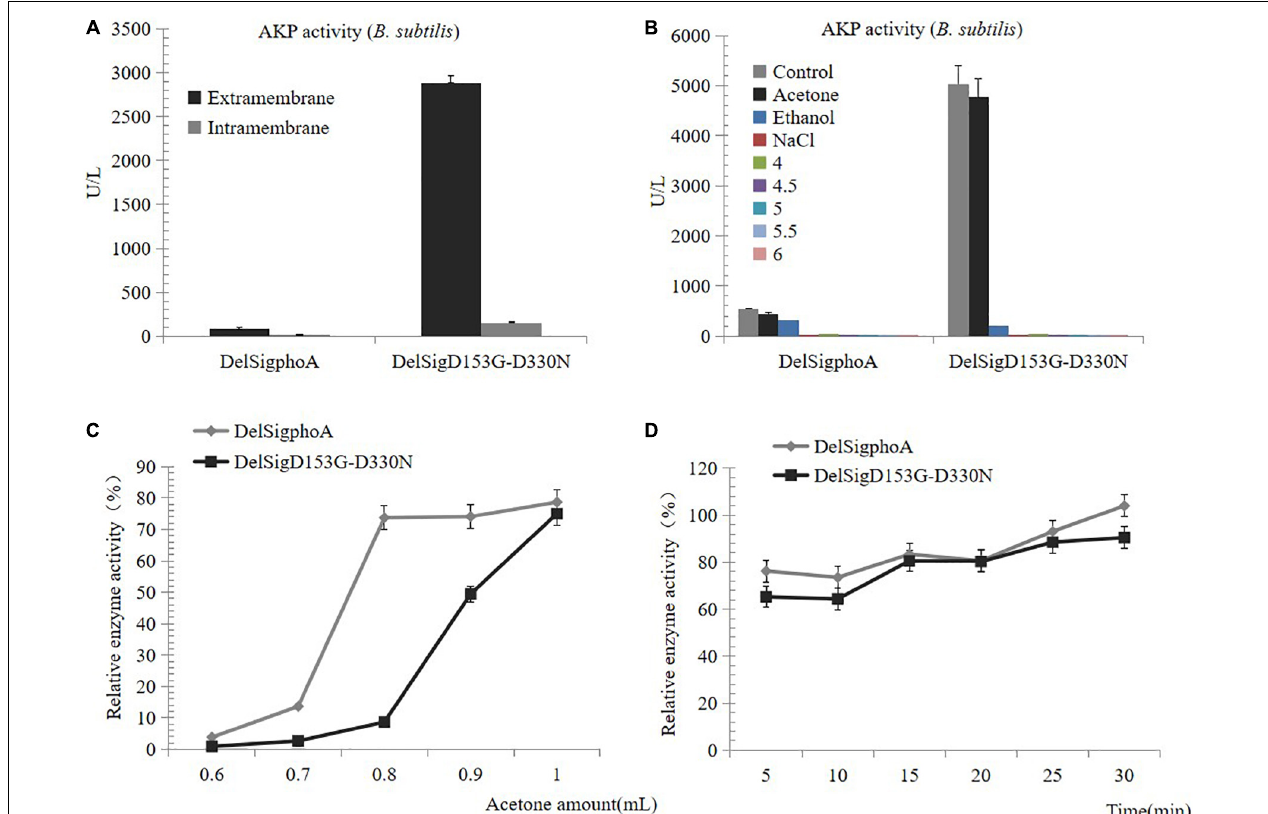
FIGURE 2 | Precipitation of AKP. (A) Distribution of AKP in fermentation broth. (B) Precipitation of AKP with acid, acetone, ethanol, and salt precipitation. (C) The effect of amount of acetone on AKP activity. (D) The effect of incubation time on AKP activity under acetone concentration (v/v) of 50%. Error bars, SD; n =